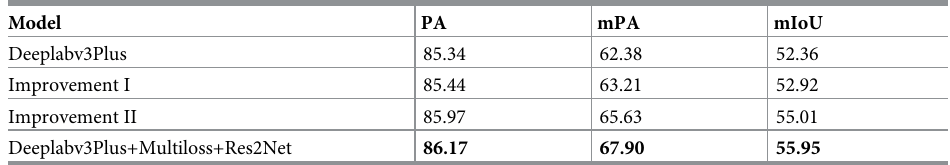
Table 4. Overall segmentation results of CamVid dataset (unit: